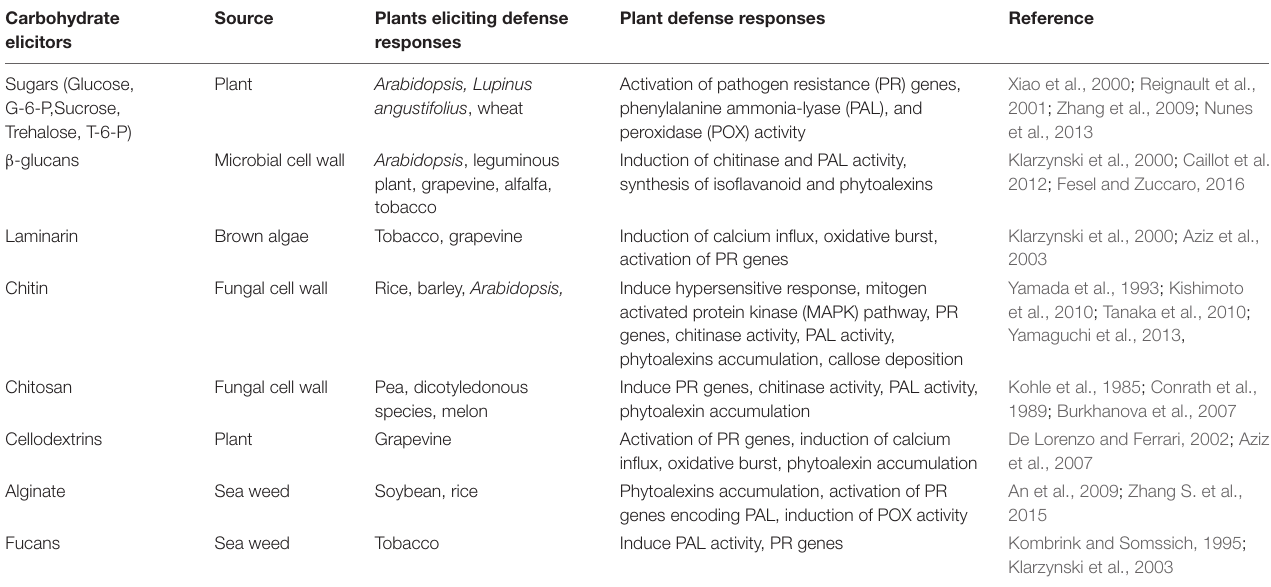
TABLE 1 | Various carbohydrate elicitors inducing defense responses in plants. Carbohydrate